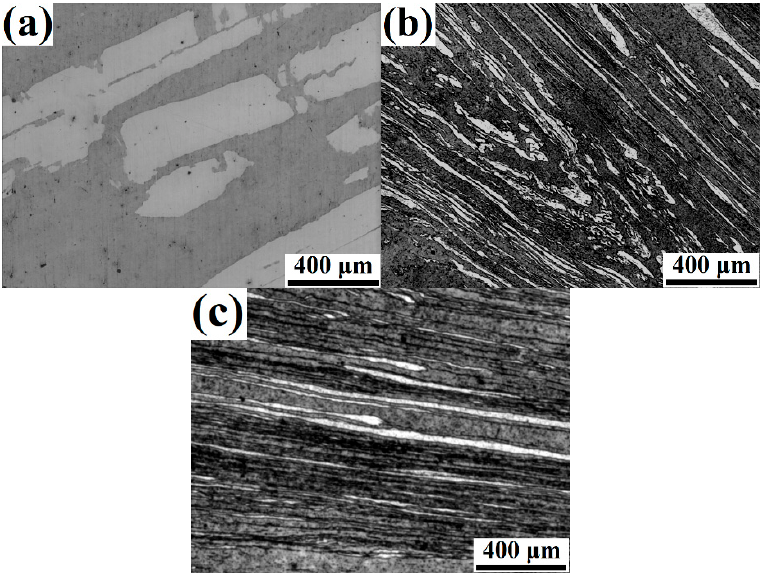
Figure 3. Optical Micrographs of Rolled Mg-9Li alloys: ( a ) CR along the rolling direction (CR-RD); ( b ) E8R along the rolling direction (E8R-RD); ( c ) E8R normal to the rolling direction ND (E8R-ND).